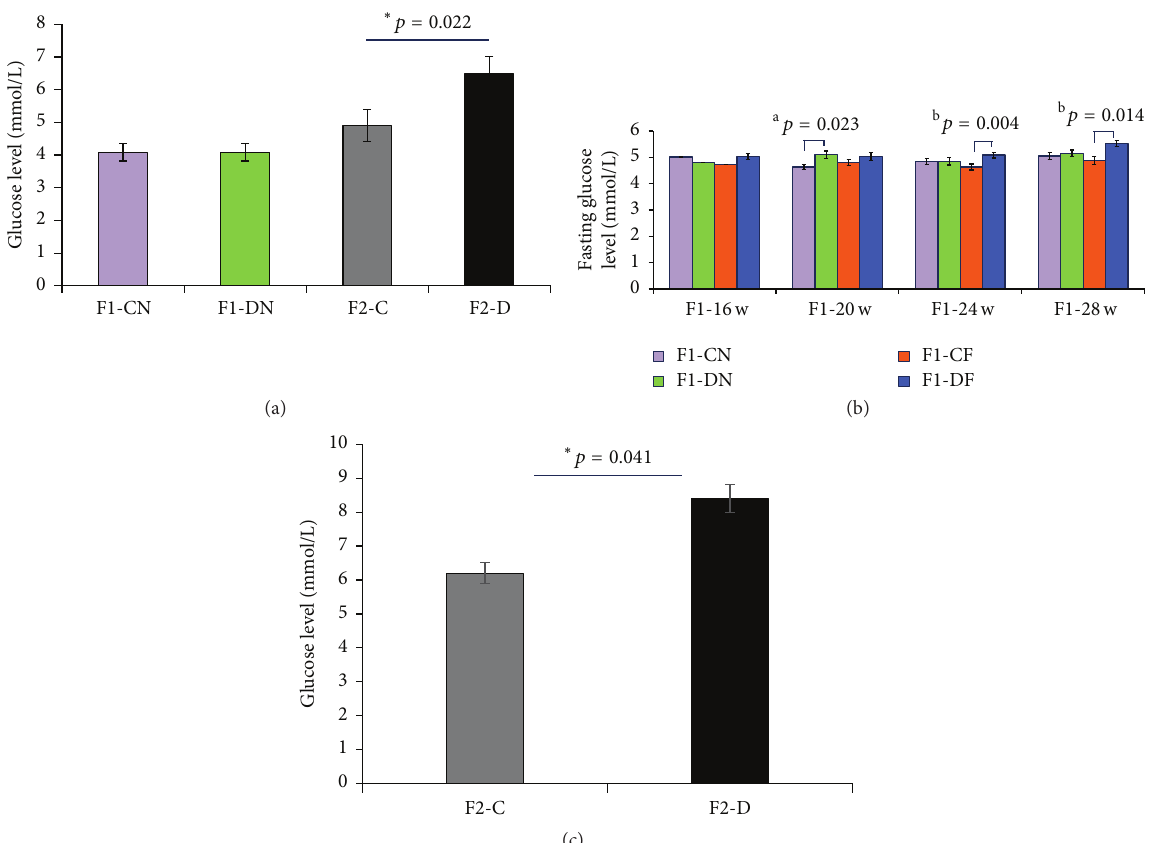
24 weeks, and there were no differences in the AUC between the F1-DN and F1-CN groups at 24 weeks (Figures 3(c) and 3(f)). The GTT revealed no difference in the glucose tolerance at 16 weeks (Figures 3(a) and